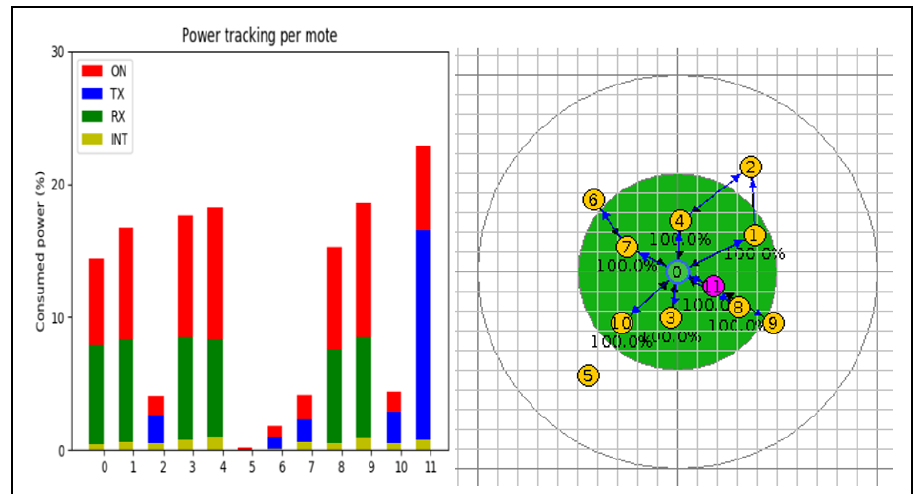
Figure 5. IoT network with malicious mote and the power usage chart.